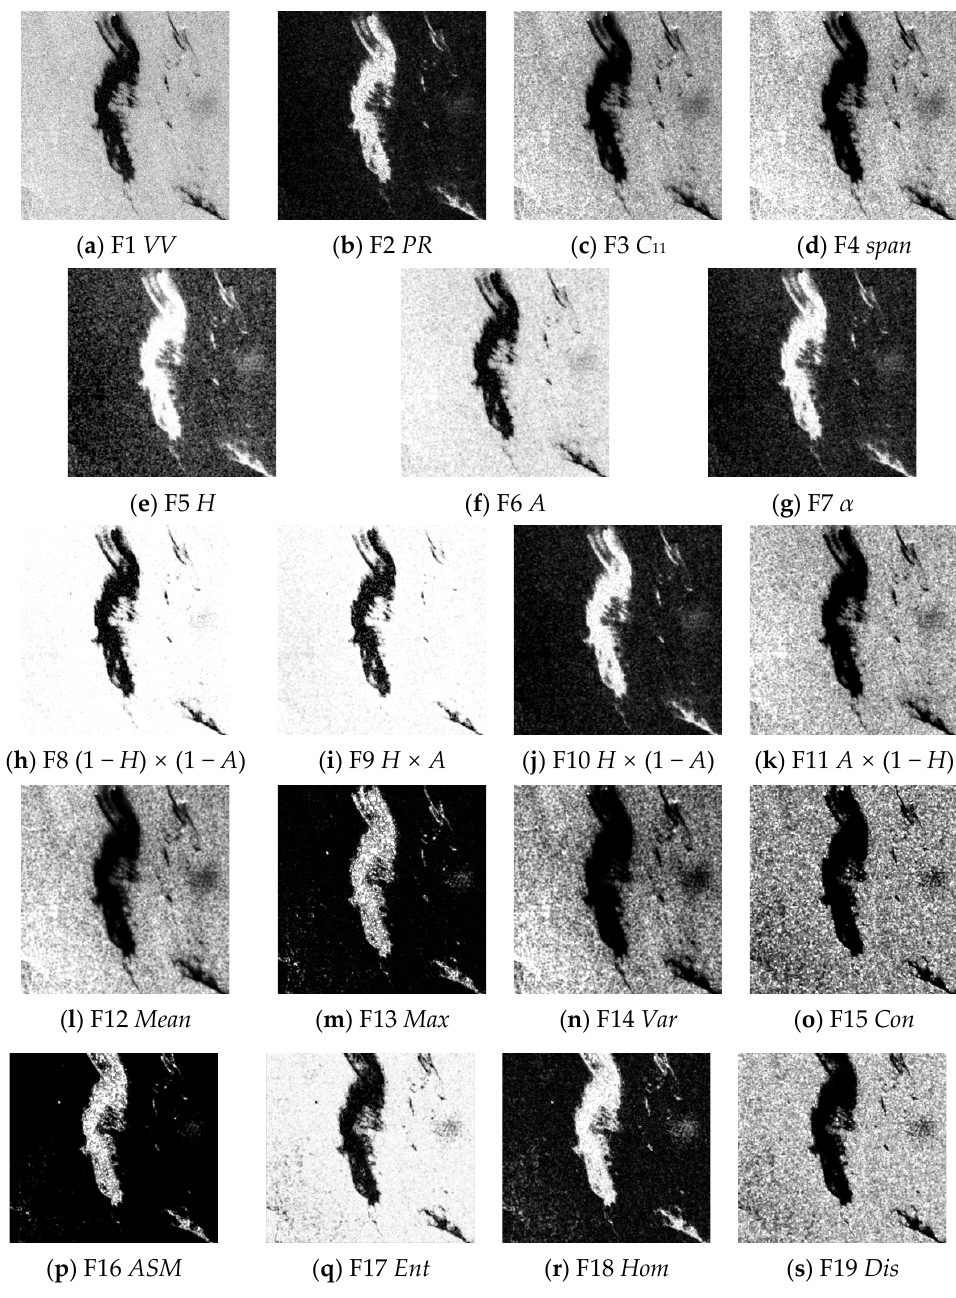
Figure 7. Data b Oil Spill Detection Features .